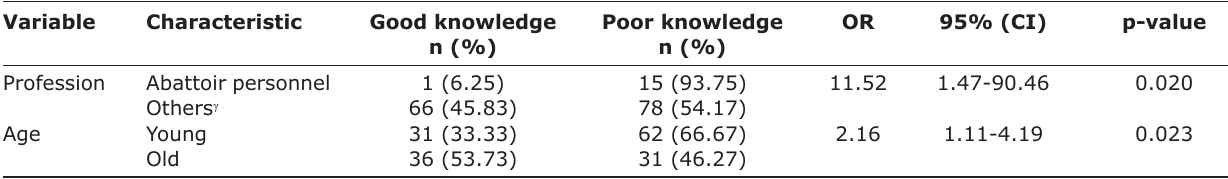
Table-3: Multivariable unconditional logistic regression analysis of factors influencing levels of knowledge about brucellosis among high-risk persons in Lafia Nasarawa State, Nigeria (n=160). Variable